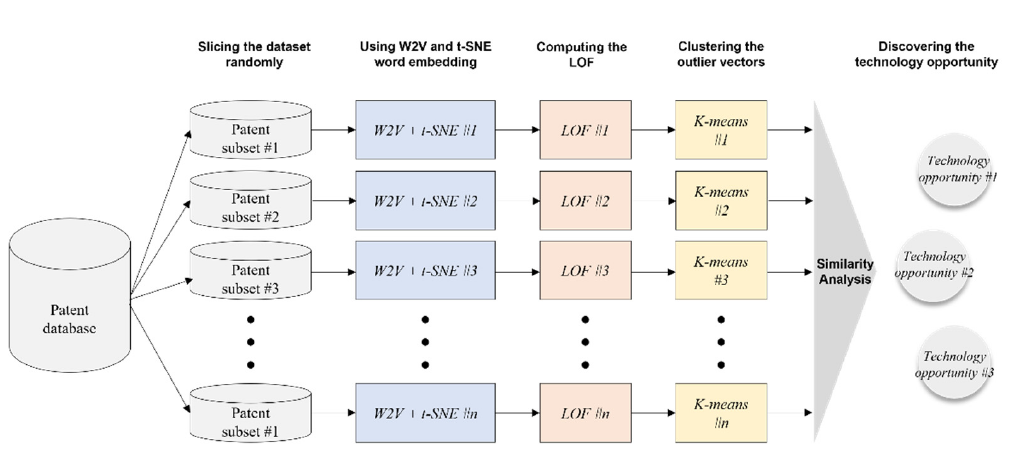
Figure 3. Concept diagram for the proposed methodology.